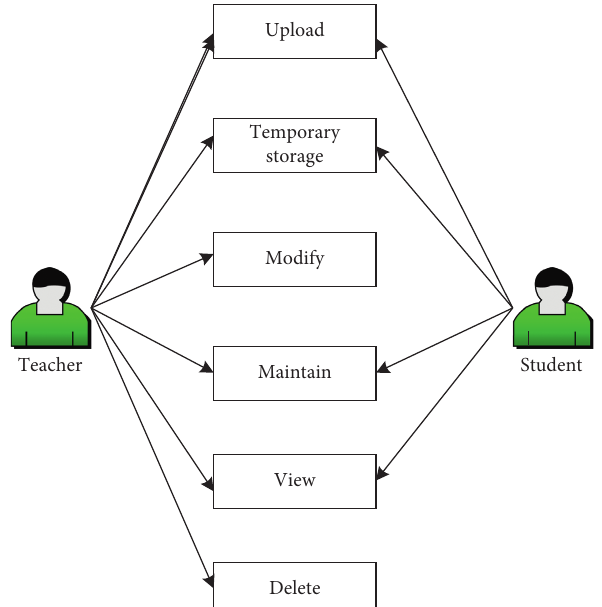
Figure 5: The I&P courses courseware management module.